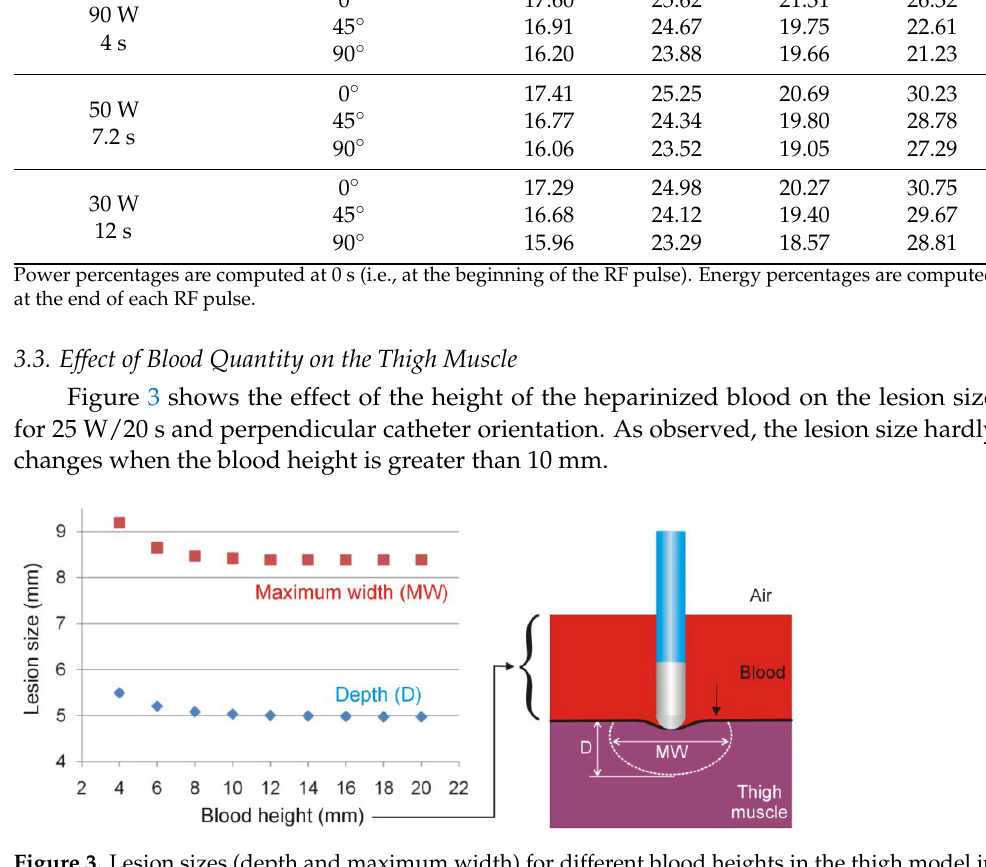
Table 4. Percentages of electrical power (P T ) and delivered energy (E T ) targeted on the tissue for myocardium (BH) and thigh muscle (TM) model.